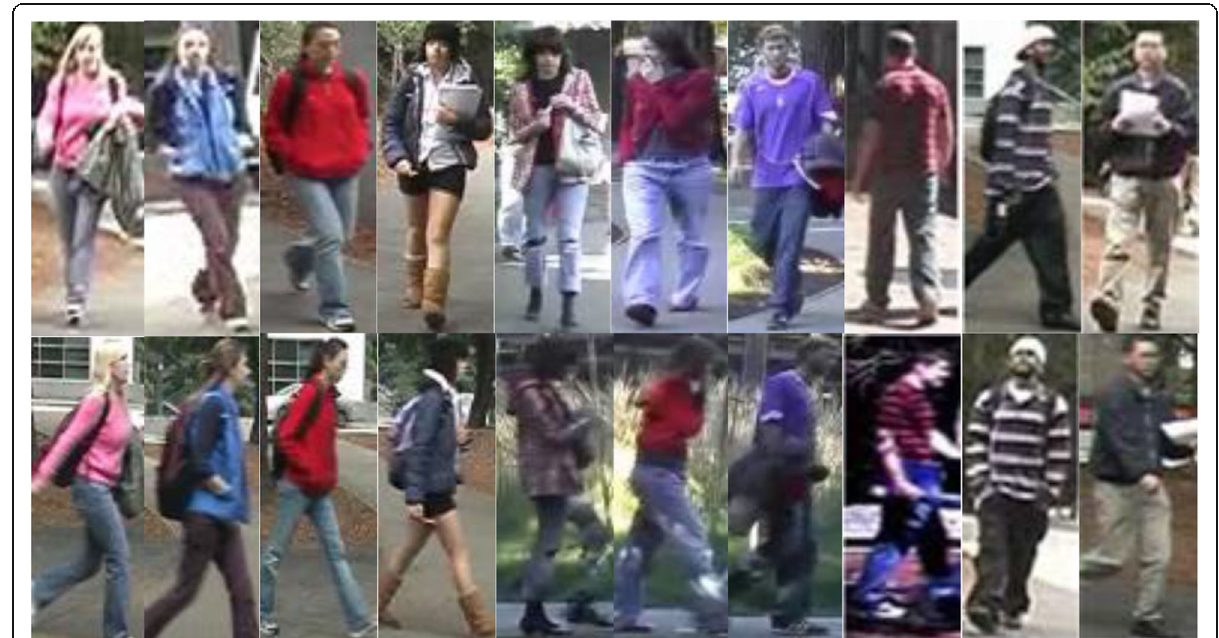
Fig. 10 Some human image-pair captured in two different